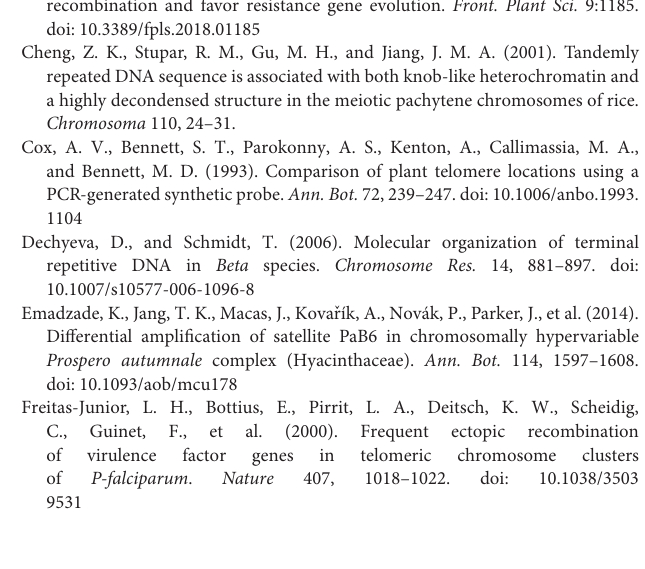
FIGURE S1 | Analysis of three major tandem repeats in the T. cinerariifolium genome. Star-like or circular graph layouts of read clusters indicative of T. cinerariifolium tandem repeats. The graph layouts corresponding to read clusters of (a) TcSAT1, (b) TcSAT2, and (c) TcSAT3 are represented. The percentage indicates the genome proportion of each cluster. FIGURE S2 | Consensus sequences of TcSAT1, TcSAT2 and TcSAT3 repeats in fasta format. Primer sequences for amplification of tandem repeat specific probes are underlined. The regions used as a probe are marked in bold. FIGURE S3 | Consensus sequences of TcSAT1 (a) , TcSAT2 (b) and TcSAT3 (c) repeats inferred from fragments reconstructed from the most frequent 27-mers (TcSAT1), 23-mers (TcSAT2) or 19-mers (TcSAT3) detected in NextSeq sequence reads. The consensus is displayed as sequence logo where the height of the letters corresponds to frequencies of corresponding k-mers. Major sequence variants are displayed along with the prevailing bases. Detailed information about reconstructed fragments used to create the consensus logos are provided as Table S3. FIGURE S4 | Dot-plot analysis of TcSAT1, TcSAT2, and TcSAT3 repeats in regard to the presence of subrepeats. FIGURE S5 | FISH mapping of TcSAT1 and TcSAT2 satellite DNA repeats on somatic metaphase chromosomes of Tanacetum cinerariifolium (2 n = 18, accession 32-2). (a) chromosomes counterstained with DAPI. (b–d) FISH mapping of TcSAT1 (green) and TcSAT2 repeats (red). Arrows in (a) point DAPI-positive